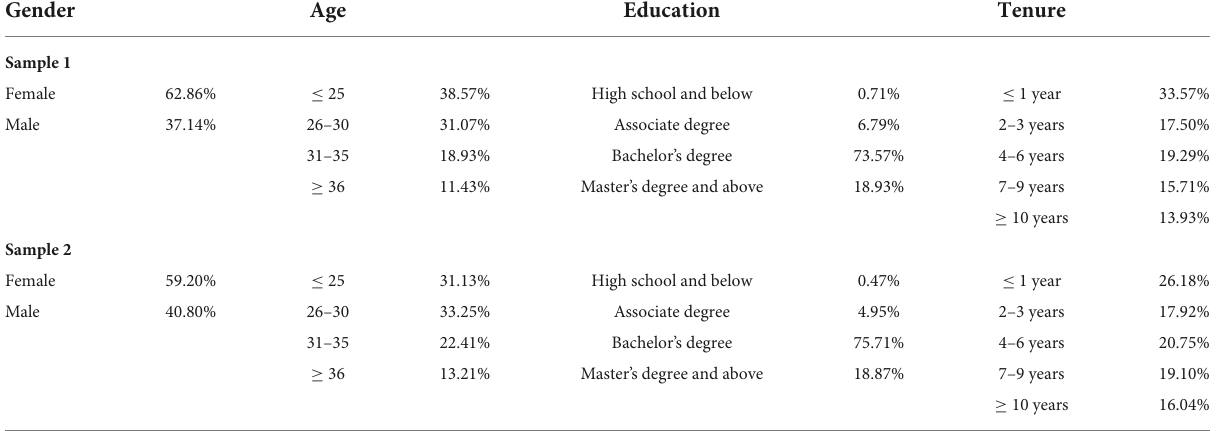
TABLE 4 Demographic characteristics of Sample 1 and Sample